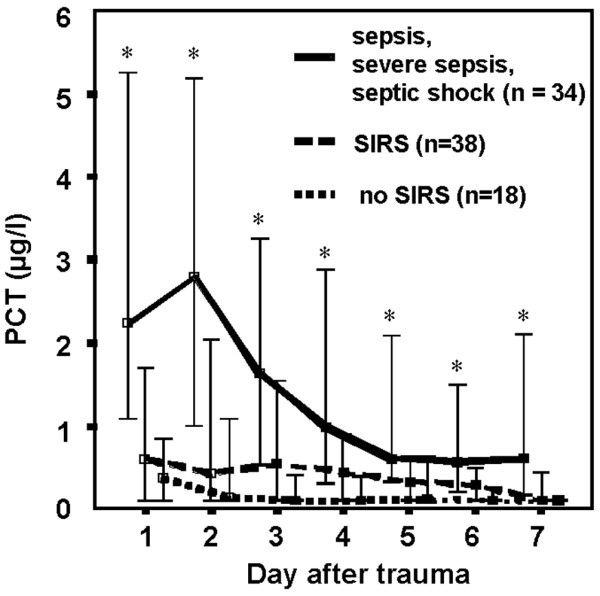
Course of procalcitonin (PCT) in patients who developed various stages of sepsis, systemic inflammatory response syndrome (SIRS), or no sepsis (median and quartiles).